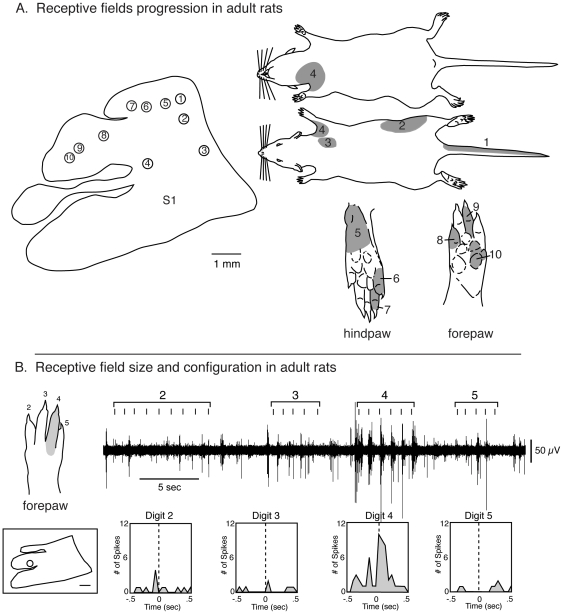
Receptive field progressions in an adult rat.Progressions of recording sites in S1 in an adult rat (left in A) and corresponding receptive fields for neurons at those sites (right in A). Numbered sites in the cortex correspond to numbered receptive fields on the body. Receptive fields are shaded grey. In adults, the topographic organization is precise and consistent across animals. As recording sites progress from medial to lateral in the caudal portion of S1 (sites 1–4) corresponding receptive fields move from the tail, lower trunk to upper trunk. The hindpaw (5–7) and forepaw (8–10) have corresponding progression from toes 5–1 and digits 5–1, respectively. Compare this figure with the full map of the body illustrated in Figure 1. B) Representative trace of cortical activity in response to stimulation of digits of the contralateral digit 4 (top left) in an adult rat. In the top left drawing of the forepaw, each digit is labeled with its corresponding number, and the receptive field on dorsal digit 4 is shaded in grey. In the bottom left is a schematic of S1 with the recording site marked with an open circle (scale = 1 mm). A trace of multi-unit activity is located to the right of the forepaw schematic. Tic marks represent the temporal pattern of stimulation. Peri-event histograms, labeled with their corresponding digit, show the increase in the amount of cortical activity in the 1 second surrounding digit stimulation.